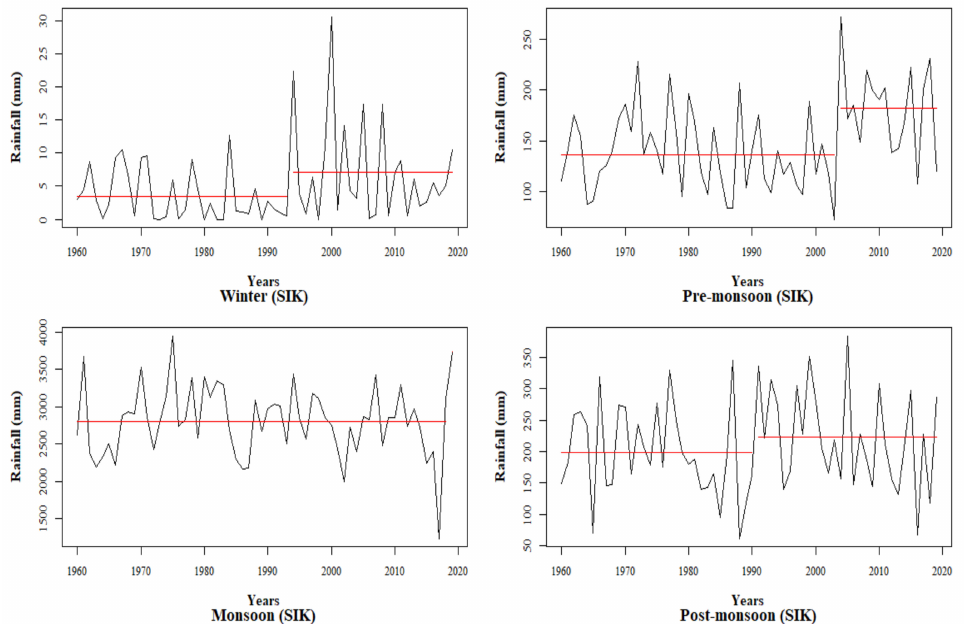
Figure 4. Seasonal rainfall distribution along with shifting pattern in SIK over the years (the change in the continuity of horizontal red line indicates the year from which shift in rainfall pattern was observed. The next line starting from above the breakage point indicates a positive shift, i.e., increase in rainfall and vice